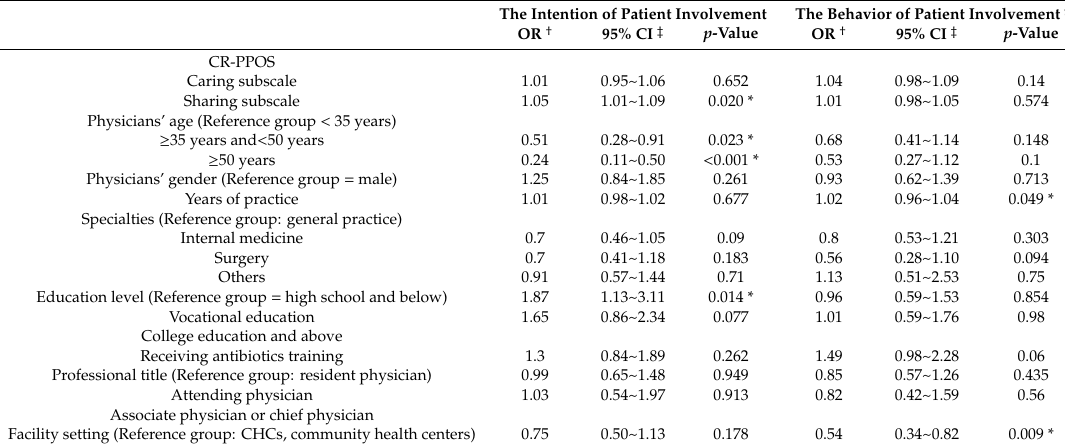
Figure 1. Comparisons of CR-PPOS scores among physician groups, based on intention and behavior of patient involvement. Note: The way of variance (ANOVA) was conducted for parameter testing and Kruskal-Wails test for non-parameter testing. Scores higher than 3.5 indicate positive attitude. ‡ represents 26 cases were missing with incomplete data of study variables. Table 3. Results from multilevel ordinal logistic regression that examine the relationship between CR-PPOS and physicians’ intention and behavior of patient involvement.